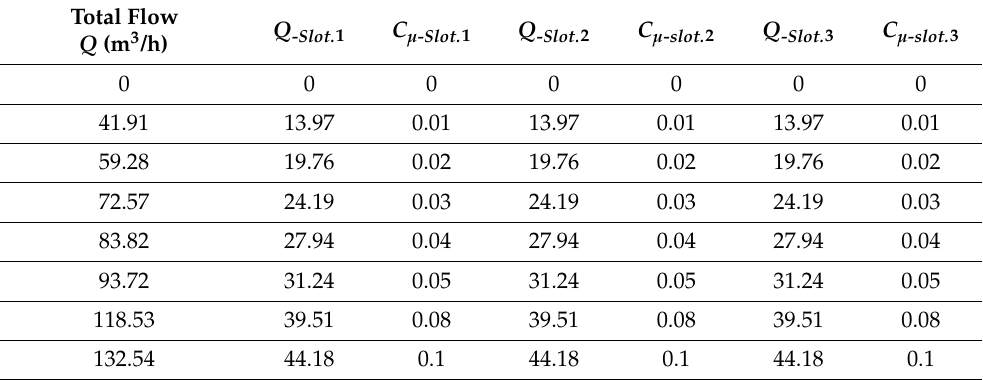
Table 3. Experimental parameters of variable blowing coefficient.